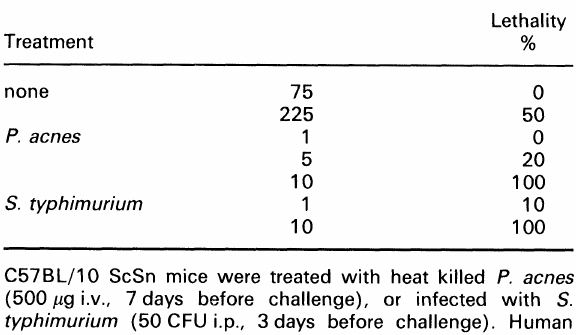
that IFN2 is the mediator of sensitization of animals treated with bacteria to the lethal activity of LPS. 2s Thus, administration of anti-IFNy monoclonal Lethality antibodies to mice pre-treated with bacteria inhibited the overproduction of TNF0 (Fig. 3) and abolished the development of sensitization to the lethal activity of LPS (Table 7).